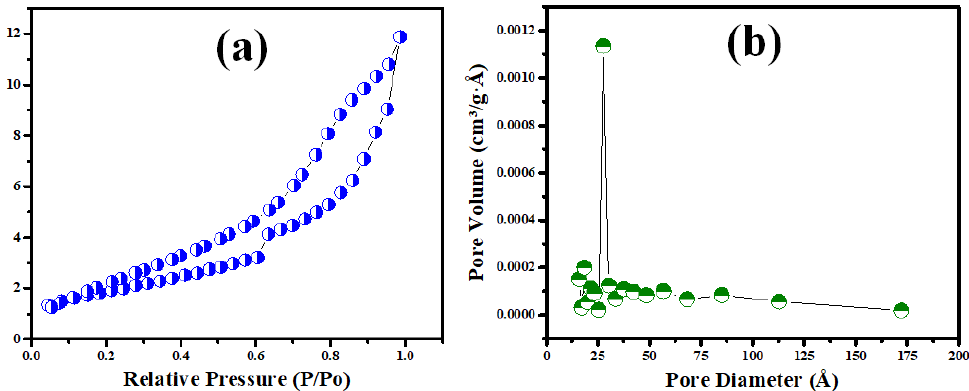
Figure 5. ( a ) The nitrogen adsorption – desorption isotherm and ( b ) the pore distribution of the